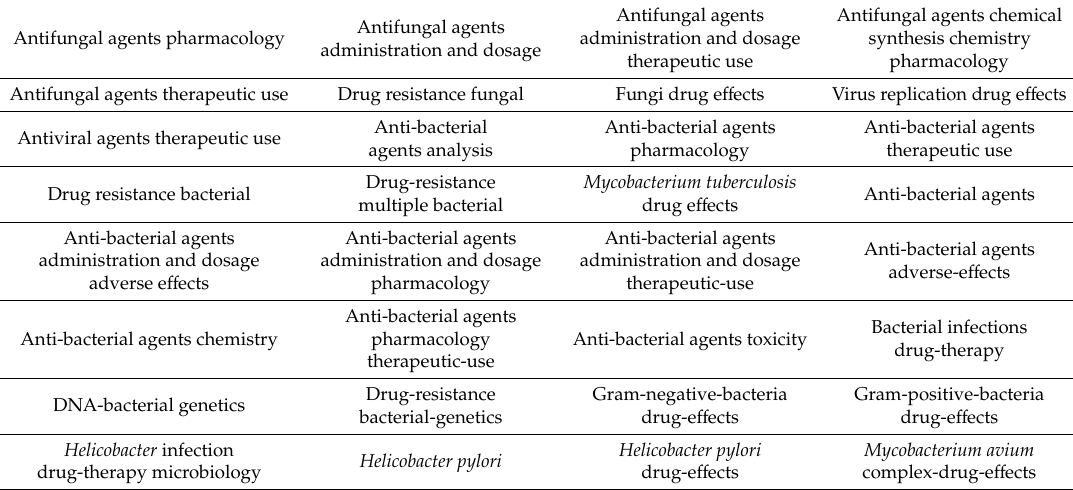
Table 1. Antimicrobial ontological